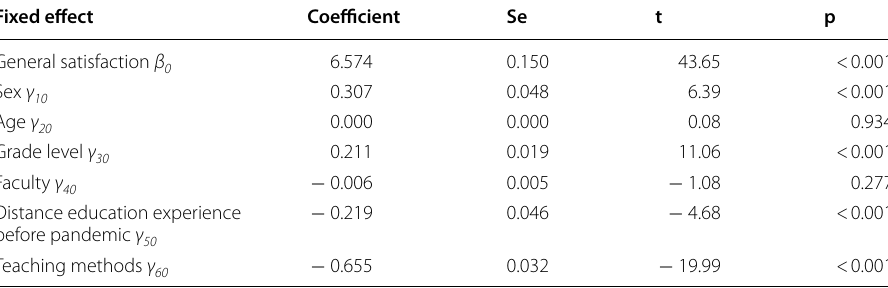
Table 4 Student variables regression model coefficients with random